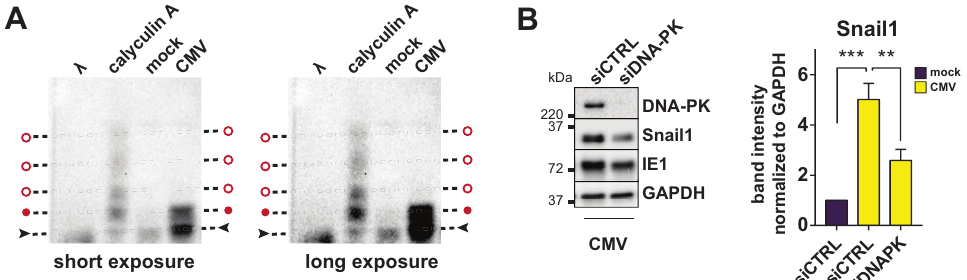
Figure 4. Snail phosphorylation and regulation by DNA-Protein kinase. ( A ) Lysates from mock- and HCMV-infected cells were harvested at 24 h p.i. and subjected to Phos-Tag SDS-PAGE. As additional controls, CMV-infected HFF were treated with a phosphatase inhibitor for 2 h before lysis (calyculin A), or with lambda phosphatase for 30 min λ ). A representative Snail1-specific immunoblot shows the ratio between unphosphorylated (black arrows) and phosphorylated Snail1 (red circles). The same blot is shown with short (left) and long exposure (right). Height of phosphorylated bands also present in the CMV condition is marked with full red circles, open red circles indicate further (weak) phosphorylation bands in the calyculin A treatment control. ( B ) Representative Western blot showing DNA-PK and Snail protein expression determined in lysates of HCMV-infected HFF transfected with a non-targeting control siRNA or DNA-PK specific siRNAs and harvested at 24 h p.i. (representative Western blot on the left and quantification relative Snail1 band intensity of multiple independent experiments on the right; asterisks show significant differences to the CMV siCTRL sample as determined by ANOVA Dunnett’s multiple comparison post-hoc